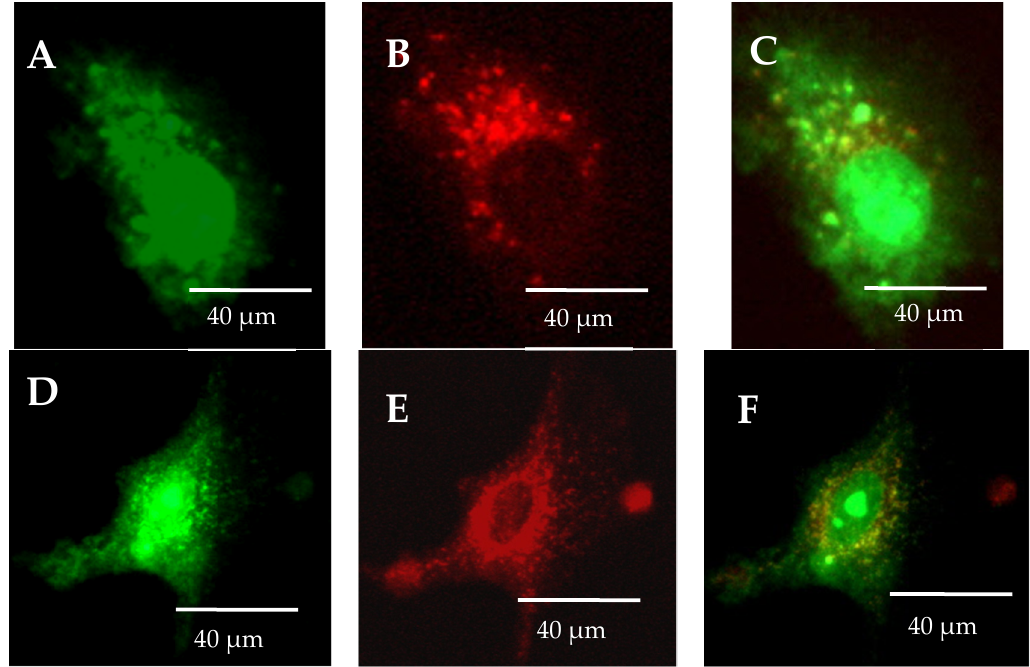
Figure 6. Differences in the occurrence of olivacine accumulation depending on the administration: ( A – C ) administration of olivacine alone causes the accumulation of olivacine (green) in lysosomes (red); ( D – F ) administration of olivacine and omeprazole causes olivacine accumulates in the cytoplasm and not in the lysosomes.